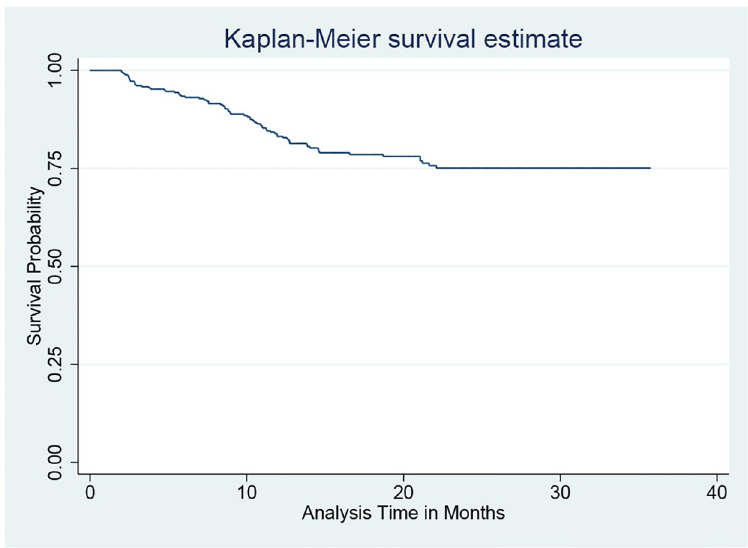
Fig 1. Overall Kaplan–Meier survival function estimates of HIV-positive women on option B+ PMTCT program in Pawi district health facilities, northwest Ethiopia, June 2013- March